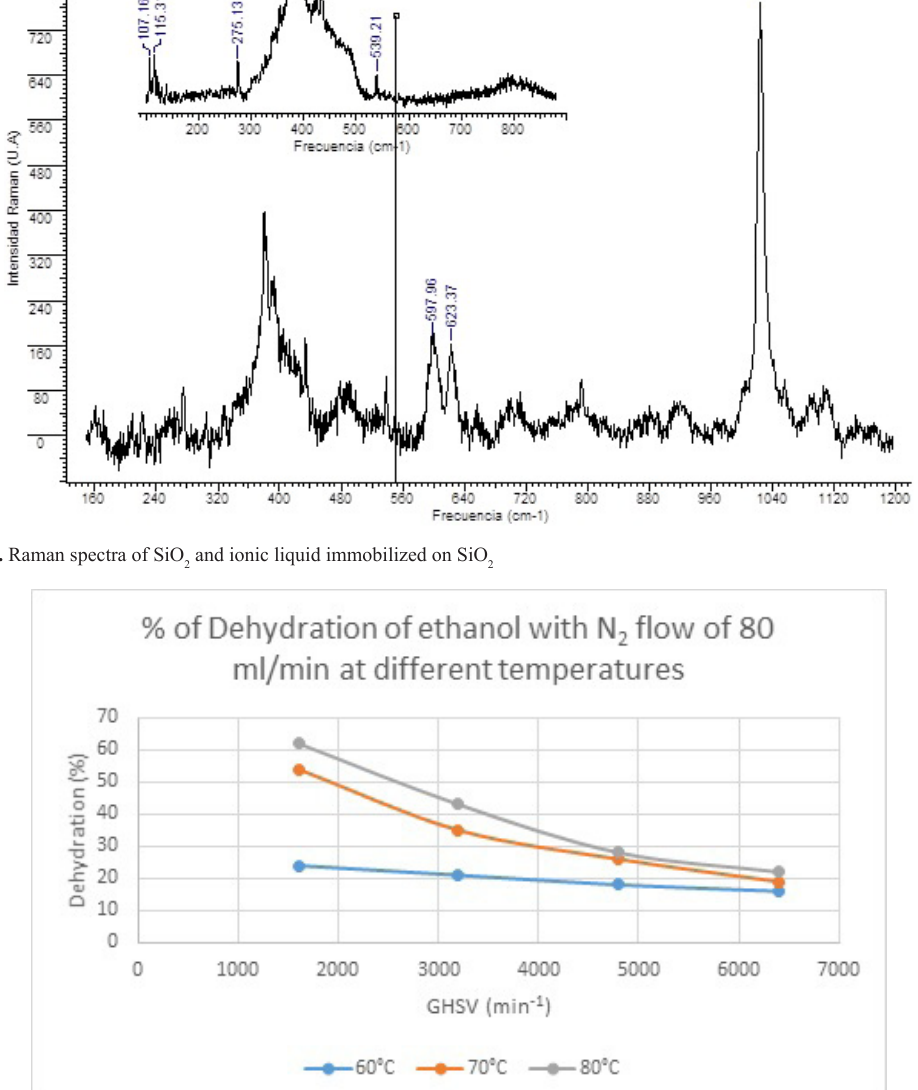
Figure 11. Dehydration of ethanol (93.45%) using the composite on a fix bed reactor with a nitrogen flow of 80 ml/min at different